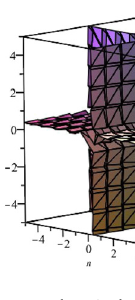
Figure 4: The fi rst Zagreb α -